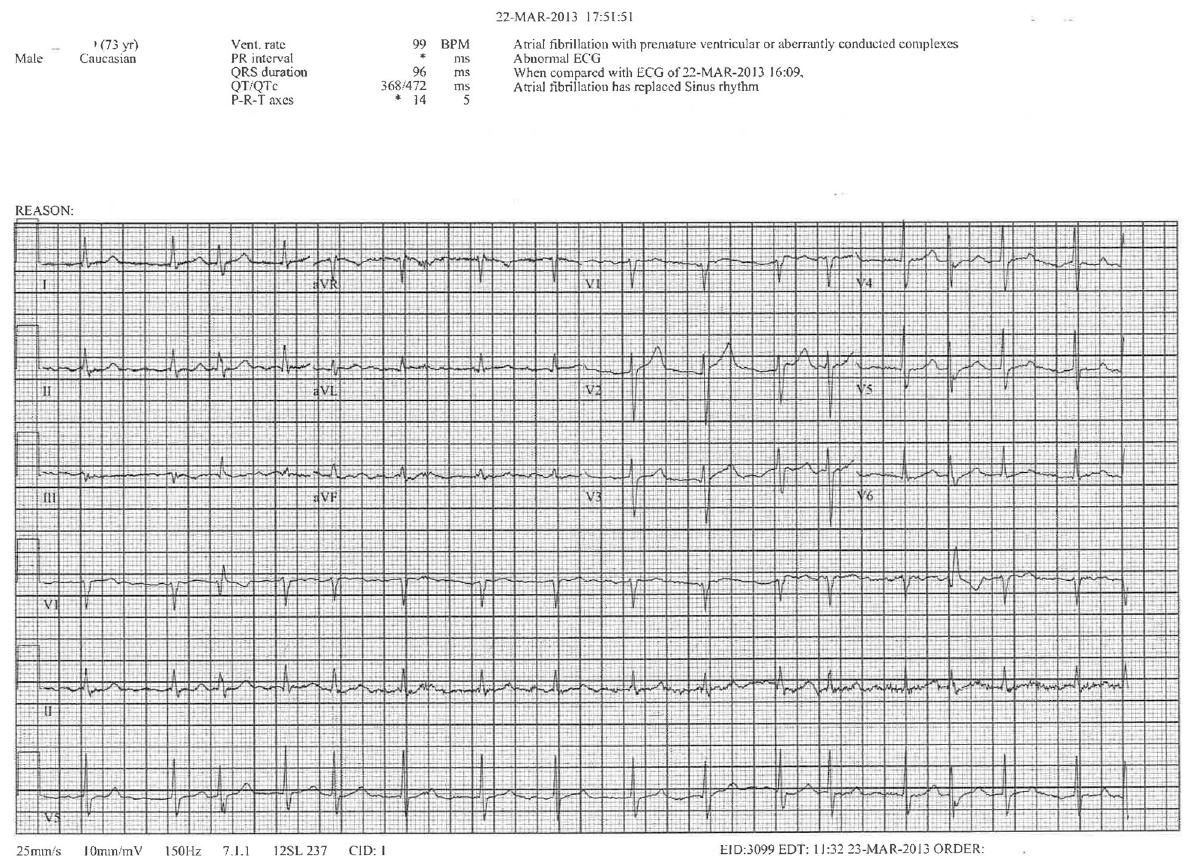
Fig. 1 Electrocardiogram obtained three hours post pit viper